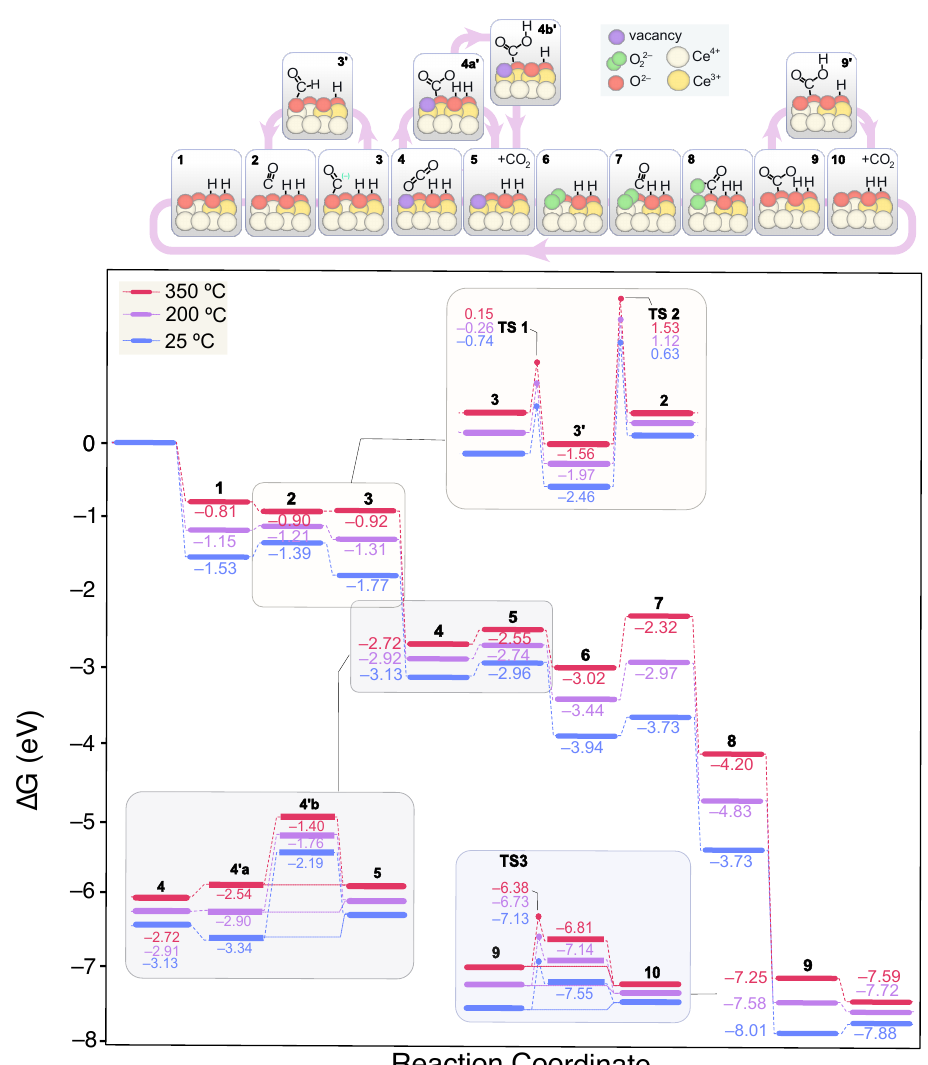
Figure 7. Calculated Gibbs energy diagram for the CO oxidation mechanism on a stoichiometric CeO 2 (111) surface covered with 2 OH groups at different experimental temperatures. The structures of the different reaction intermediates are depicted at the top of the